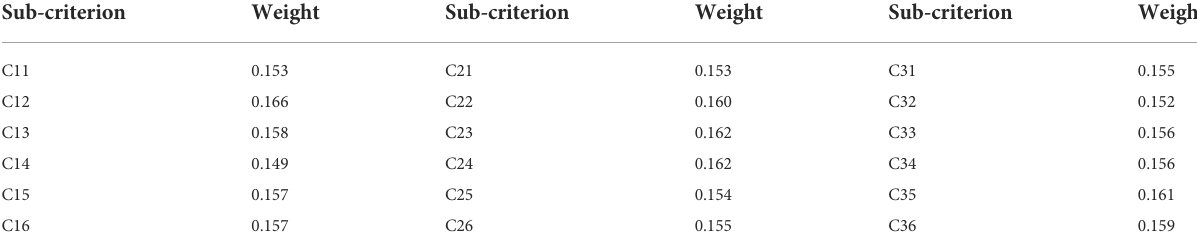
TABLE 6 Weight values of sub-criteria.